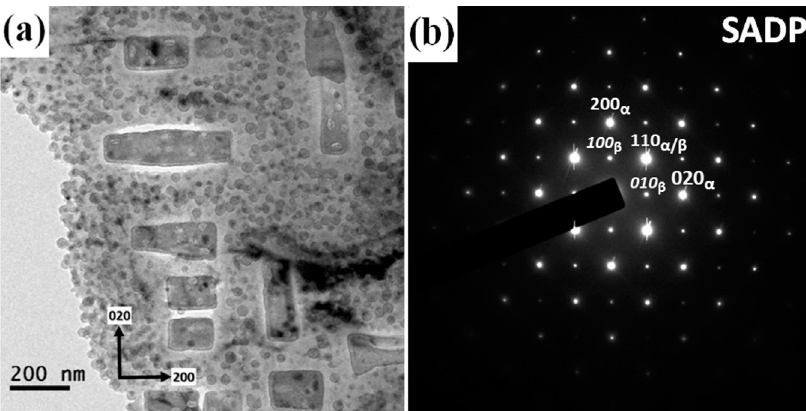
Figure 5. (a) BF-TEM micrograph of the Fe-10at.%Ni-15at.%Al-5at.%Cu alloy aged at 850 °C for 5 h, and (b) its corresponding